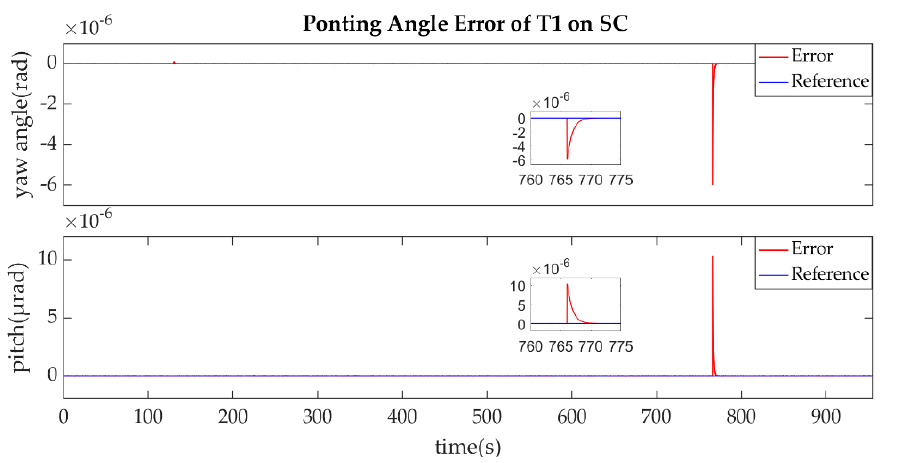
Figure 21. Ponting Angle of T1 on SC. Figure 22. Ponting Angle Error of T1 on SC.